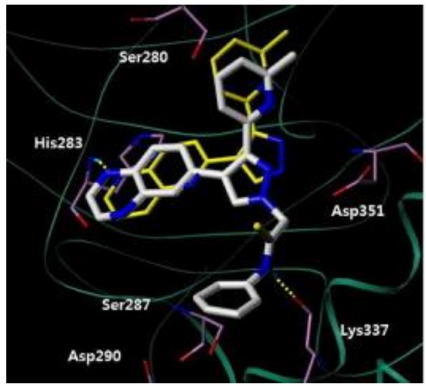
Figure 85. Binding pose of compound 78 in the active site of ALK5, superimposed over the X-ray pose of 1,5-naphthyrine inhibitor (yellow carbon). Yellow dotted lines indicate hydrogen bonding interactions (<2.5 Å) [90].